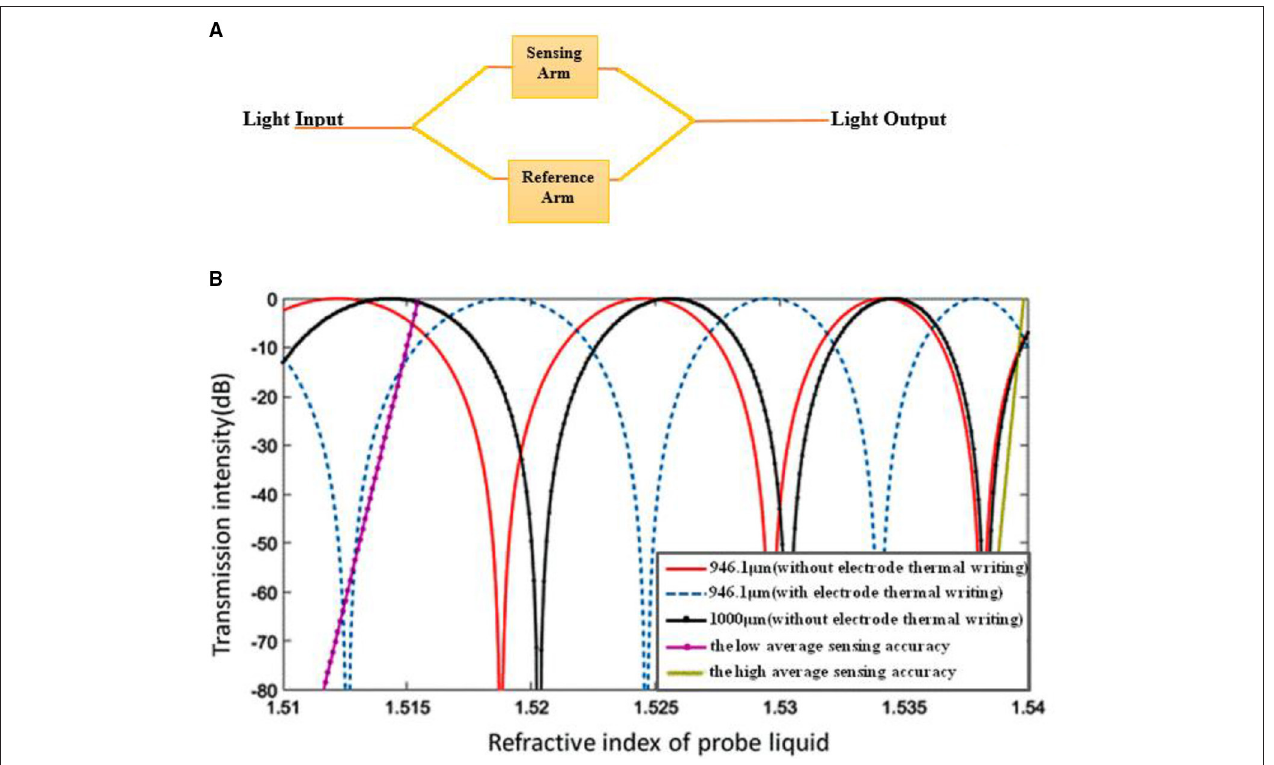
FIGURE 3 | (A) Mach-Zehnder Interferometer working process, (B) intensity of sensor with various length and refractive index of core (6).